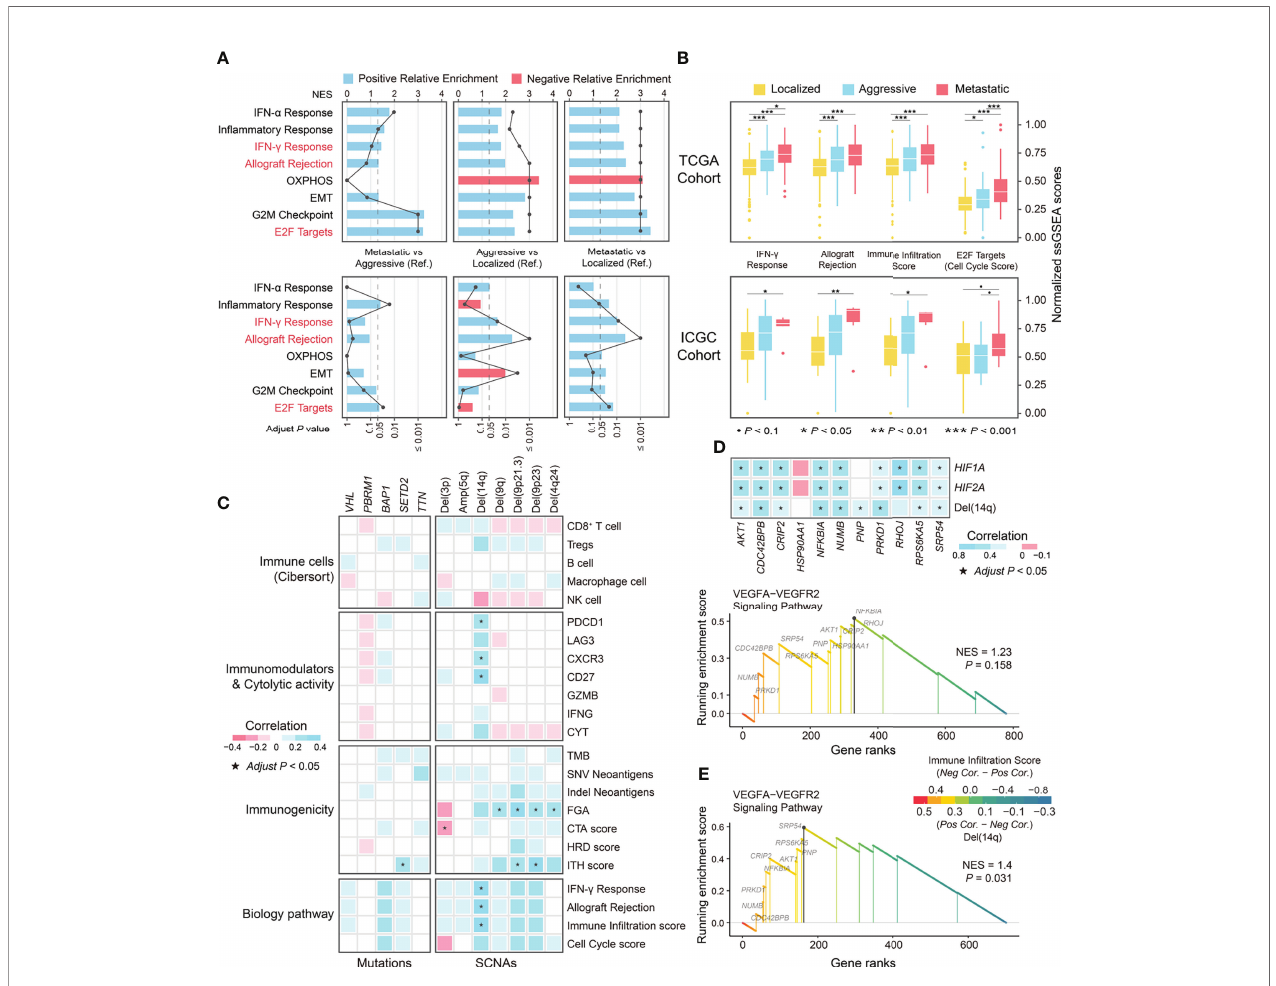
FIGURE 7 | The differential biological processes among phenotypes in ccRCC and correlation of genomic alterations and immune-related indicators. (A) The differences in biological processes among phenotypes of ccRCC derived from GSEA. (B) Boxplot showing the differences in normalized ssGSEA scores of differential biological processes among phenotypes of ccRCC. (C) Correlation of genomic alterations and indicators related to immune escape and biological processes. (D) GSEA plot of the enrichment pathway on genes at 14q associated with immune in fi ltration score and correlation between leading edge genes with indicators including SCNA levels and expression of HIF1A and HIF2A . (E) GSEA plot of the enrichment pathway on genes at 14q associated with corresponding SCNAs. OXPHOS, Oxidative phosphorylation; EMT, Epithelial- Mesenchymal Transition; Pos, Positive; Neg, Negative; Cor, Correlation coef fi cient; NES, Normalized Enrichment